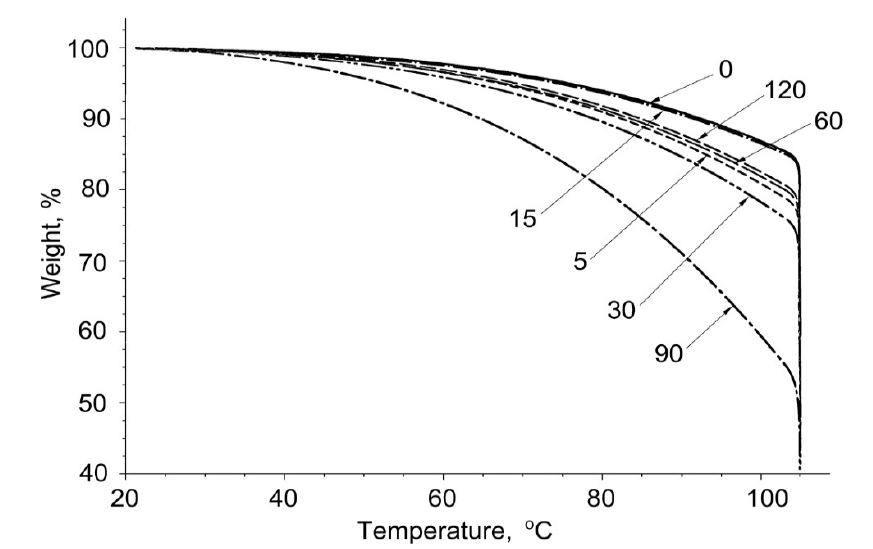
Figure 7. Thermograms of water treated with GP for 0 to 120 min measured after 10 days. Speed 10 ◦ C / min. It meant that until the boiling point of those samples was reached the samples lost consecutively 46.0, 24.7, 22.5, 20.6, 19.5, 16.0, and 15.5% of their